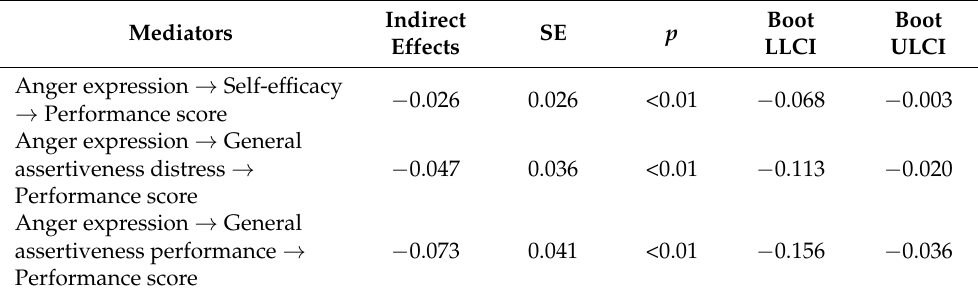
Table 4. Summary of indirect effects and confidence intervals of three mediators